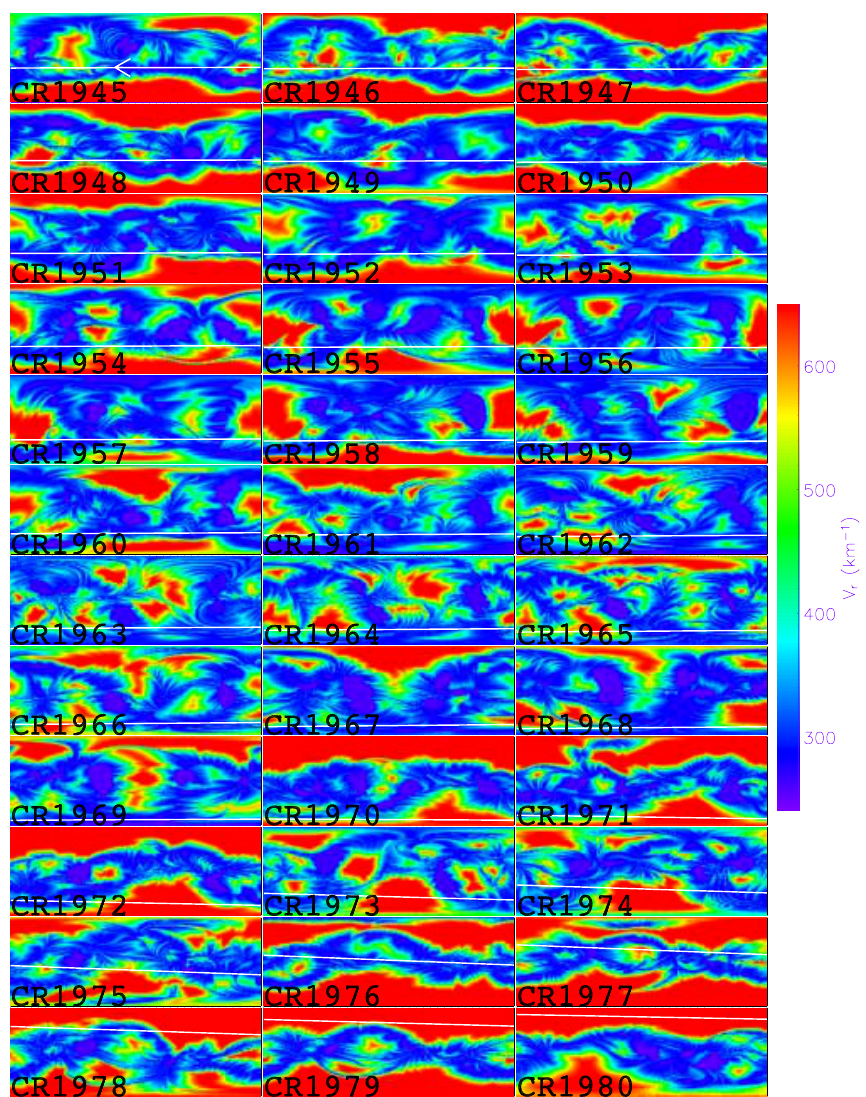
Fig. 4. Computed radial velocities for CR1945 to CR1980. The solid line in each panel indicates Ulysses’ mapped trajectory along this spherical